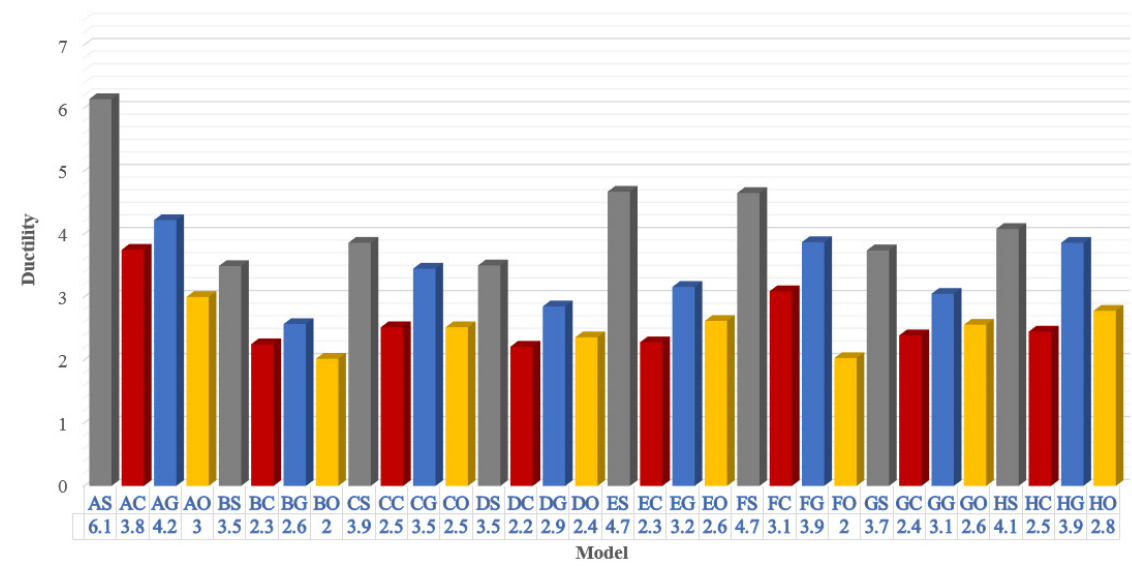
Figure 18. Ductility of the models